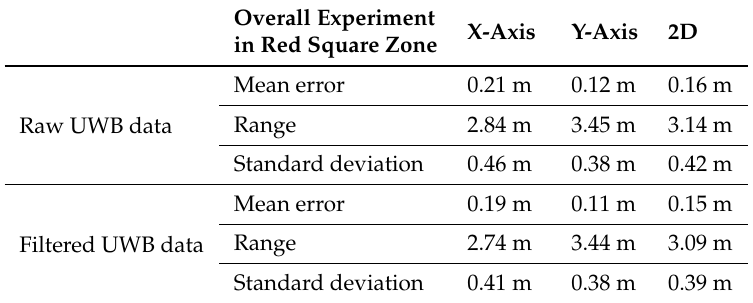
Figure 12. Comparison of the trajectory of the worker from station 1 between UWB filtered and not filtered in blue. In orange the motion capture system. ( a ) UWB system without Sav–Gol filter in blue and motion capture system in orange. ( b ) UWB system with Sav–Gol filter in blue and Motion capture system in orange. Table 2. Comparison with filtered data and raw data with the MoCap system as